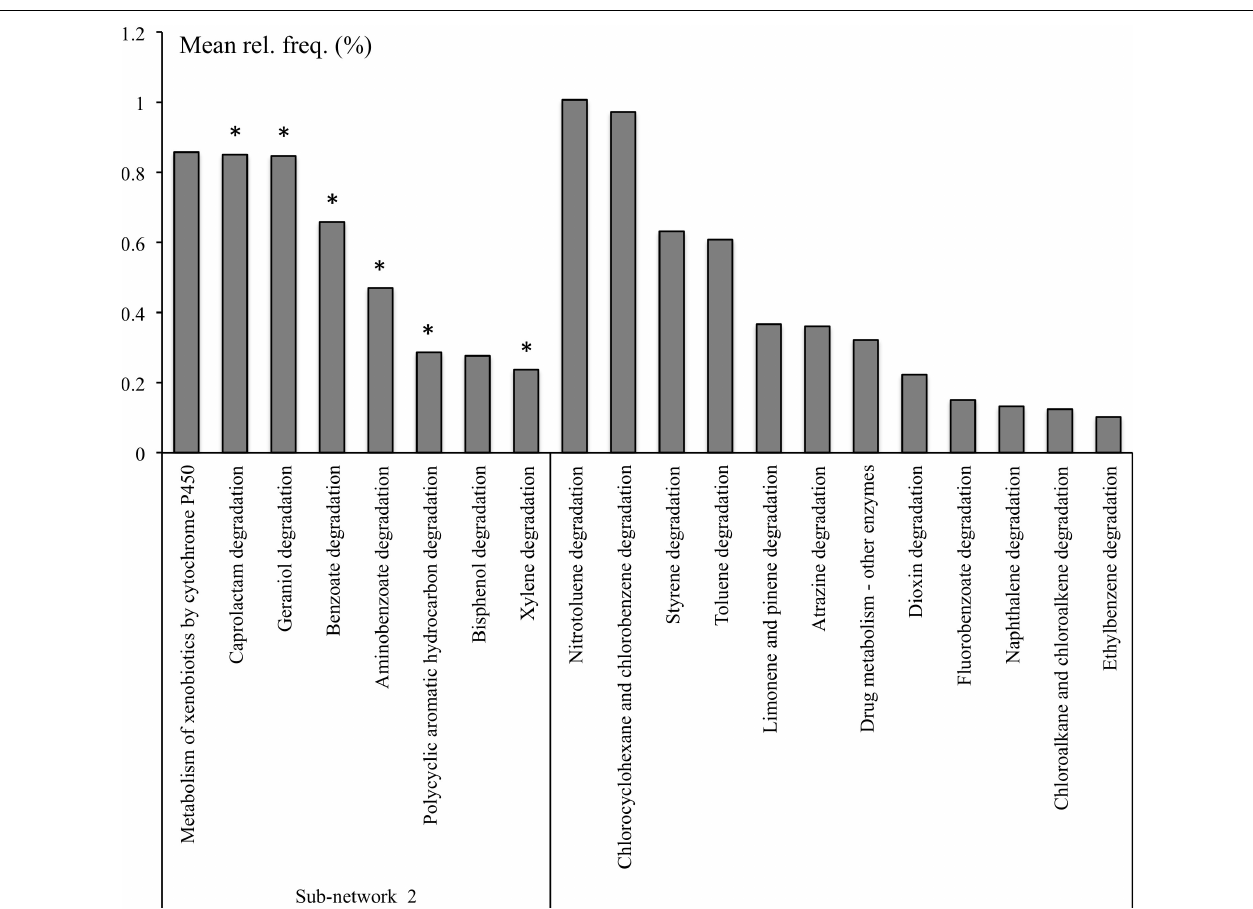
FIGURE 3 | Selected KEGG pathways of xenobiotics, terpenoids, and polyketides metabolism in microbial metagenomes from bulk and rhizosphere soils from natural and managed habitats. ∗ Pathways overrepresented in rhizosphere.